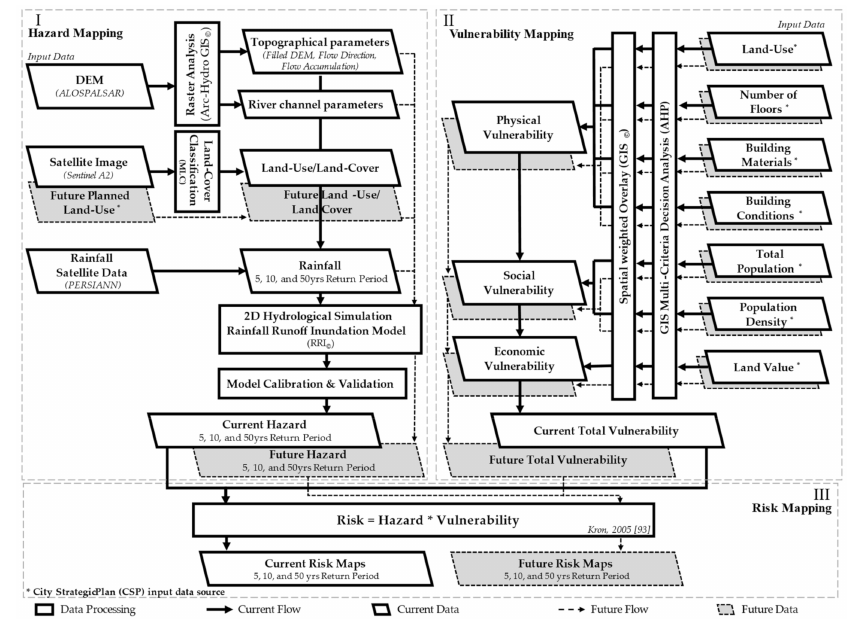
Figure 3. Flowchart for data processing and